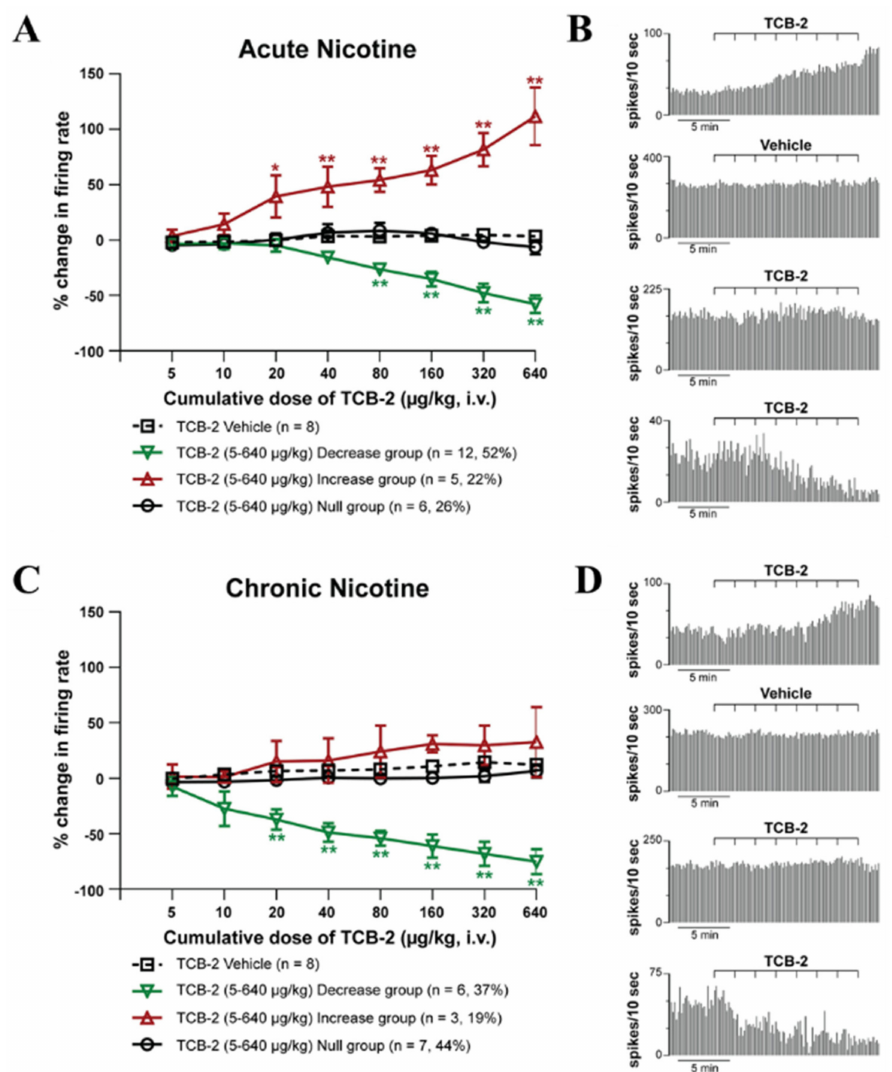
Figure 3. ( A ). The dose-response curve of TCB-2 (5–640 µ g / kg, iv) 60 min after a single acute treatment of nicotine (2 mg / kg, i.p.). The data are shown as the mean % change in firing rate ± SEM. The majority of neurons (52%) responded with a decrease in firing rate, with peak e ff ect at 640 µ g / kg ( − 57.8 ± 7.9%). The remaining neurons responded with an increase in firing rate (22%, peak e ff ect at 640 µ g / kg, 111.7 ± 26.1%), or showed no change in firing rate (26%). One-way ANOVA with repeated-measures, followed by Tukey’s post hoc test, * p < 0.05 vs Vehicle, ** p < 0.005 vs Vehicle. ( B ) Typical rate histograms of single neuronal recordings that showed an increase in firing, a control neuron, no change in firing, and a decrease in firing (sequentially from top to bottom). ( C ) A dose-response curve of TCB-2 (5–640 µ g / kg, i.v.) after chronic treatment of nicotine (6 mg / kg / day for 14 days). Almost an equal number of neurons responded with no change in firing rate (44%) or with a decrease in firing rate (37%, peak e ff ect at 640 µ g / kg, − 75.0 ± 11.4%). The remaining neurons responded with a small, not significant increase in firing rate (19%, peak e ff ect at 640 µ g / kg, 32.7 ± 31.4%). ( D ). Typical rate histograms of single neuronal recordings that showed an increase in firing, a control neuron, no change in firing, and a decrease in firing (sequentially from top to bottom). One-way ANOVA with repeated-measures, followed by Tukey’s post hoc test, * p < 0.05 vs Vehicle, ** p < 0.005 vs. Vehicle. After chronic treatment of nicotine (6 mg / kg / day for 14 days), TCB-2 (5–640 µ g / kg, i.v.) induced almost in an equal number of neurons either no change in firing rate ( n = 7; 44%) or a decrease in firing rate ( n = 6; 37%) with a peak e ff ect at 640 µ g / kg of − 75.0 ± 11.4% ( p < 0.005; post-hoc Tukey test)